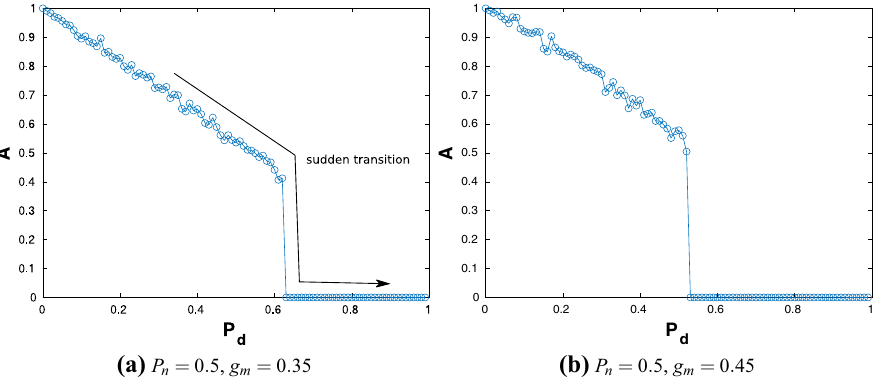
Figure 2. The order parameter A plotted as a function of P d for P n = 0.5 and ( a ) g m = 0.35 and ( b ) g m = 0.45 exhibiting sudden AT.